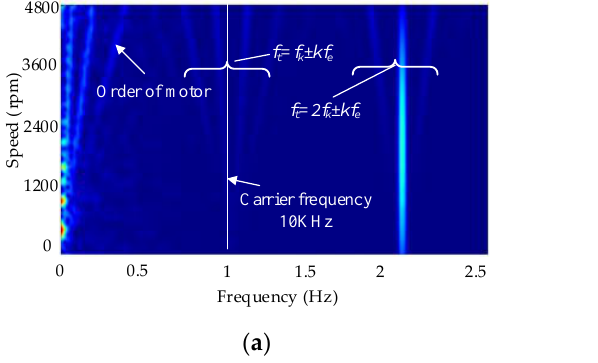
Figure 26. NVH performance of the motor: ( a ) color map of electromagnetic torque; ( b ) time-frequency domain of motor angular acceleration.